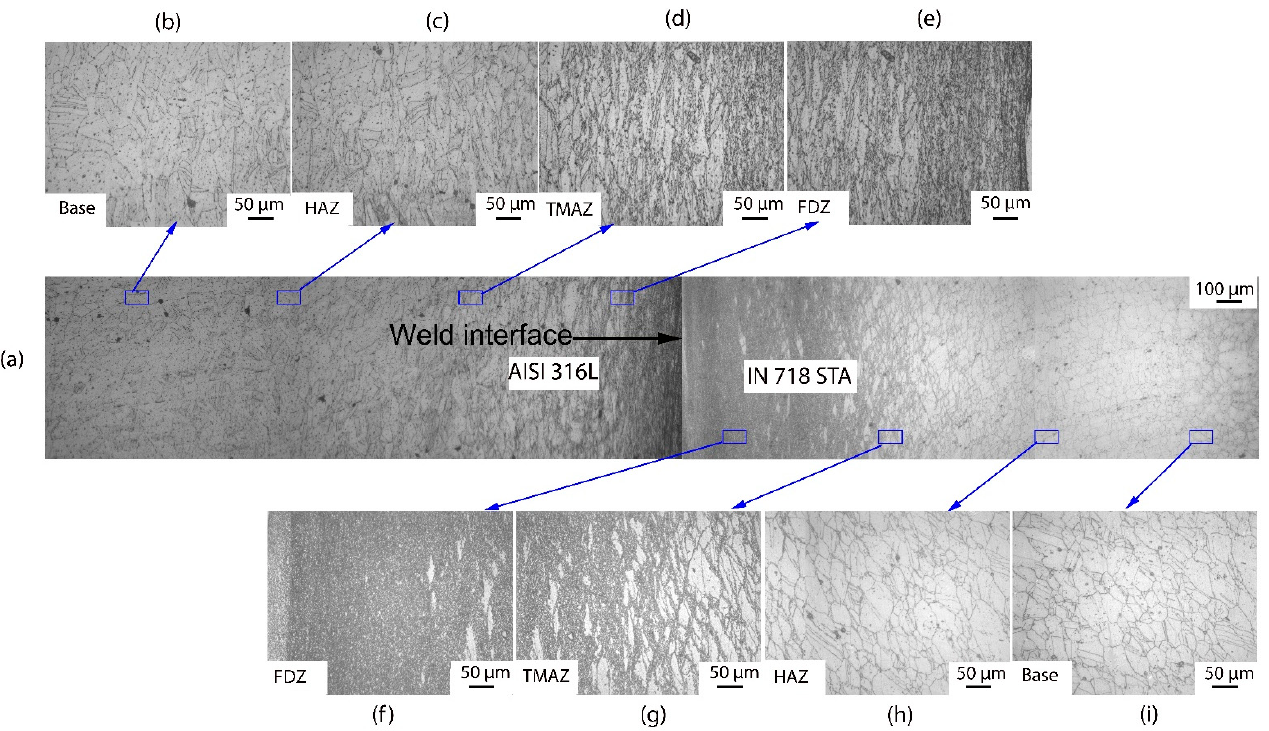
Figure 6. Cross-sectional view of weld joint interface of dissimilar friction weld AISI 316L-IN718 STA condition: ( a ) weld interface; ( b ) base metal on AISI 316L side; ( c ) HAZ on AISI 316L side; ( d ) TMAZ on AISI 316L side; ( e ) FDZ on AISI 316L side; ( f ) FDZ on IN718 side; ( g ) TMAZ on IN718 side; ( h ) HAZ on IN718 side; and ( i ) base metal on IN718